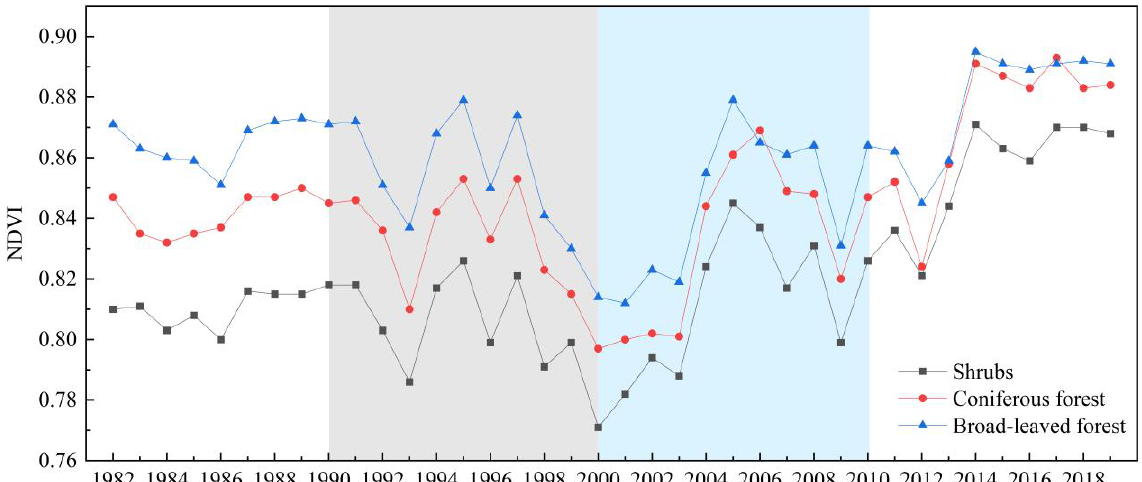
Figure 15. NDVI change trends of three forestlands in eastern Inner Mongolia. The gray highlights the period of excessive logging in the Daxinganling Mountains in the 1990s, and the blue highlights the construction period of the first stage of the natural forest protection project.